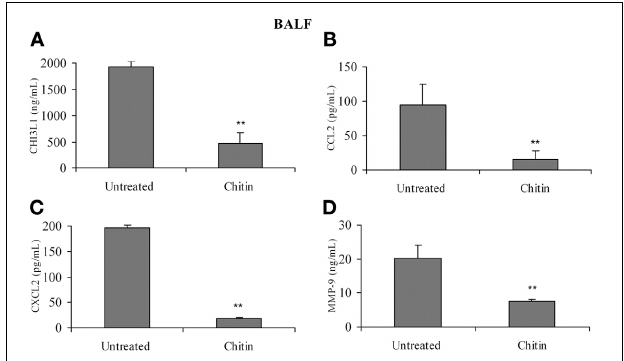
FIGURE 8 | In vivo treatment with chitin microparticles decreases CHI3L1, CCL2, CXCL2, and MMP-9 expression in BALF. BALF from untreated and chitin treated mice at 5 weeks post-tumor implantation was analyzed for: (A) CHI3L1; (B) CCL2; (C) CXCL2; and (D) MMP-9 expression by ELISA. For all experiments, N = 10/group; ∗∗ p ≤ 0 . 001.